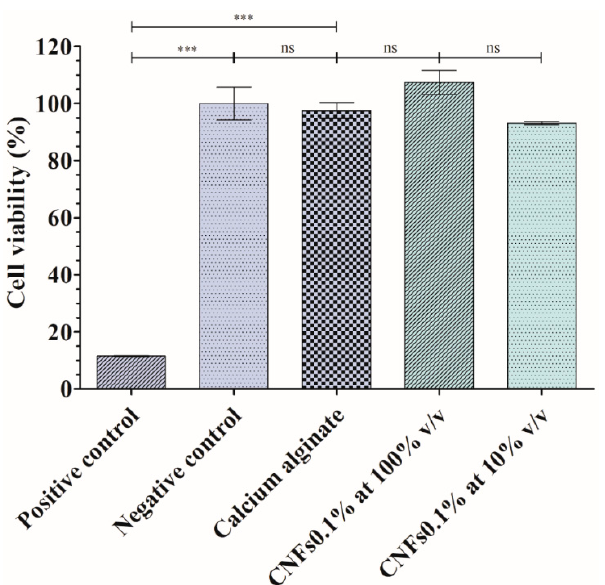
Figure 5. Cell viability (%) of extracts of calcium alginate (at 100% v / v ) and calcium alginate/CNFs films (at 100% and 10% v / v ), culture medium (negative control), and 1000 µ M zinc chloride cytotoxic solution (positive control) in human keratinocyte HaCaT cells. Only significant statistical differences were found with the negative control. *** p > 0.001; ns: not significant.